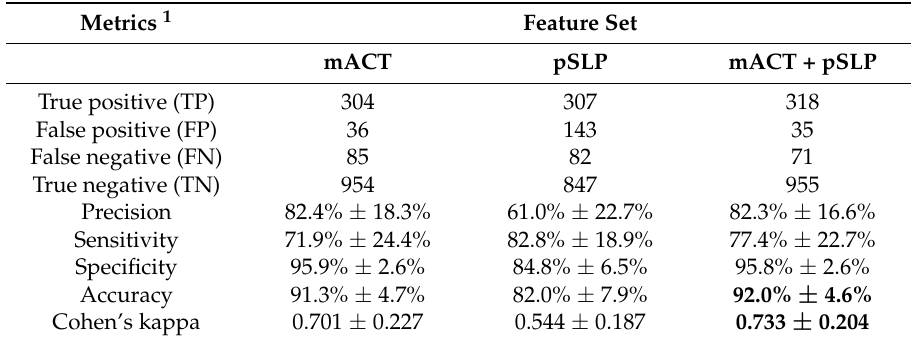
Table 1. Comparison of wake and sleep classification results (leave-one-subject-out cross validation— LOOCV) with video-based actigraphy.